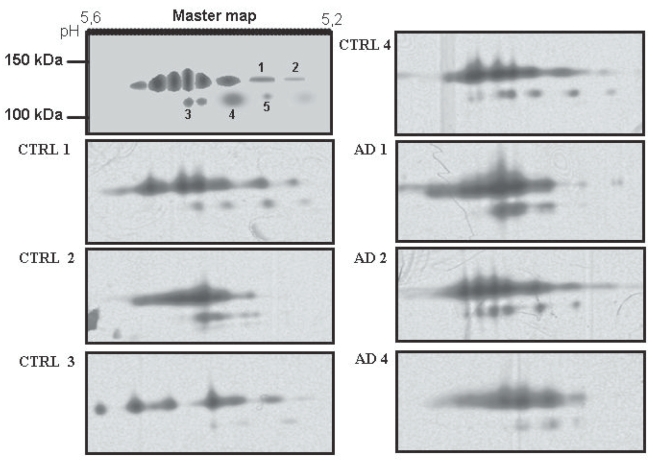
2D quantitative analysis of serum ceruloplasmin isoforms at 135 and 115 kDa. A master map created by using PDQuest software from a triplicate of AD sample and a quadruplicate of control sample. The optical density analysis of the spots did not show statistically significant differences between AD and control sample.